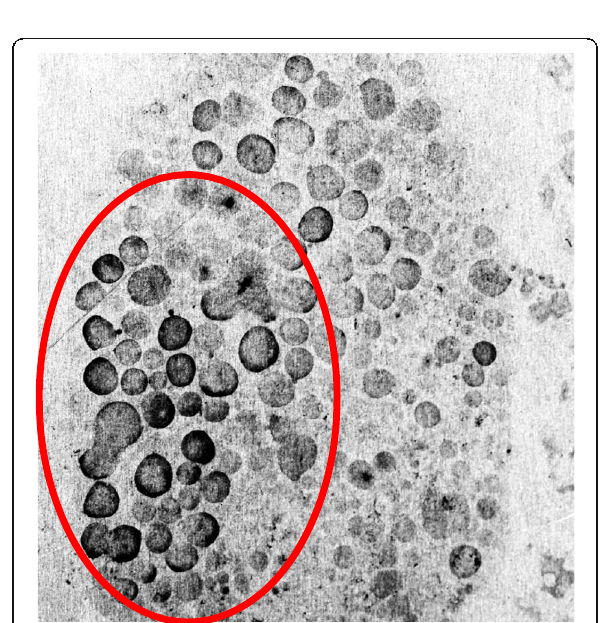
Fig. 6 Water speckles observed on developed fingermark